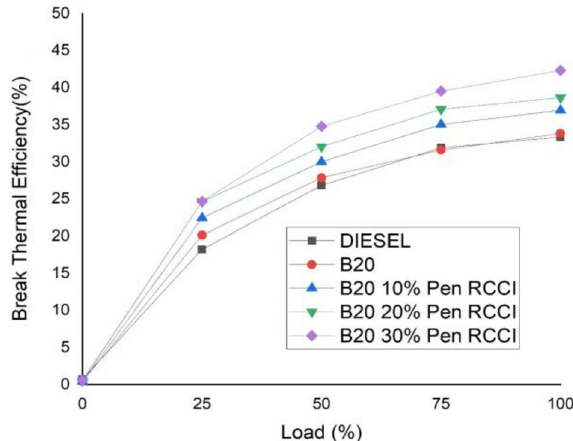
Figure 4. Break thermal efficiency versus